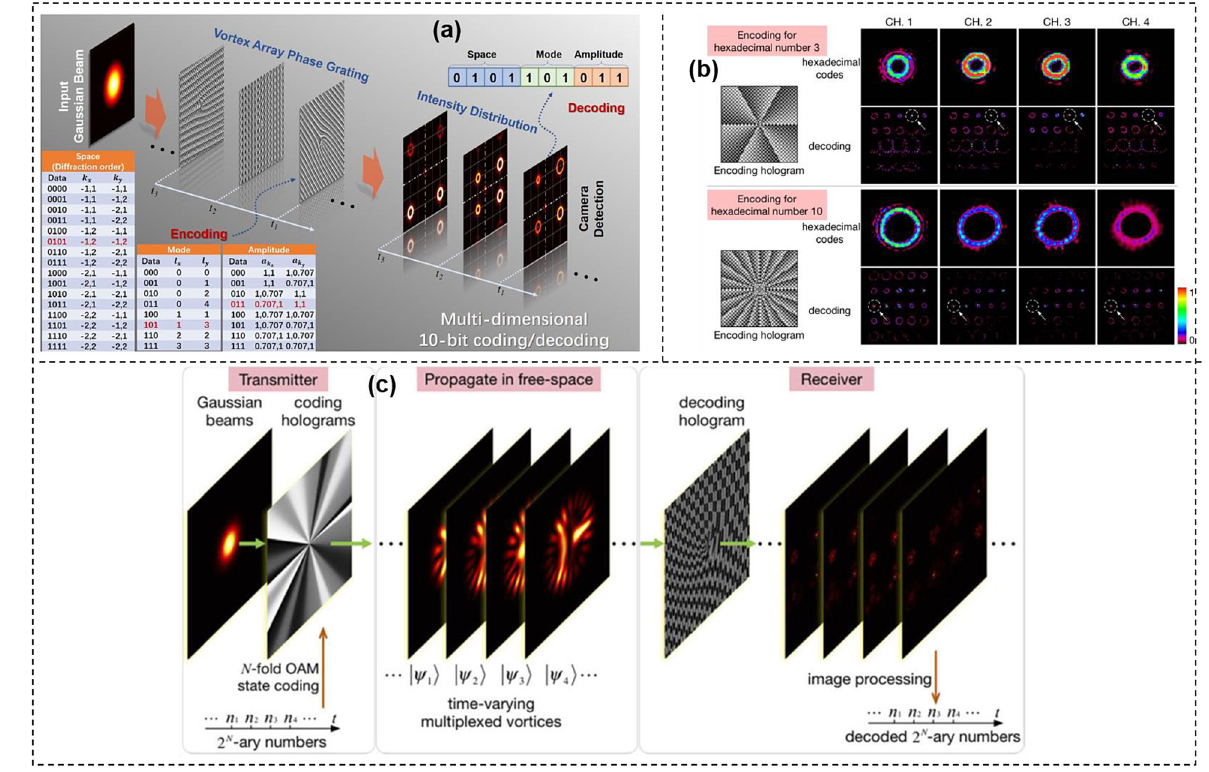
Figure 8: More examples of OAM array modulation communications. (a)The conceptandprincipleof multi-dimensionalspace/mode/amplitudecoding/decoding usingthevortexarray phasegrating.The coding table was shown in the lower-left corner [82]. (b) Hexadecimal codes and their corresponding decoding patterns captured experimentally by each channel in digital signal multicopy replication [83]. (c) Concept of data transmission based on multi-state OAM shift keying [84]. Reprint permission obtained from [82 –